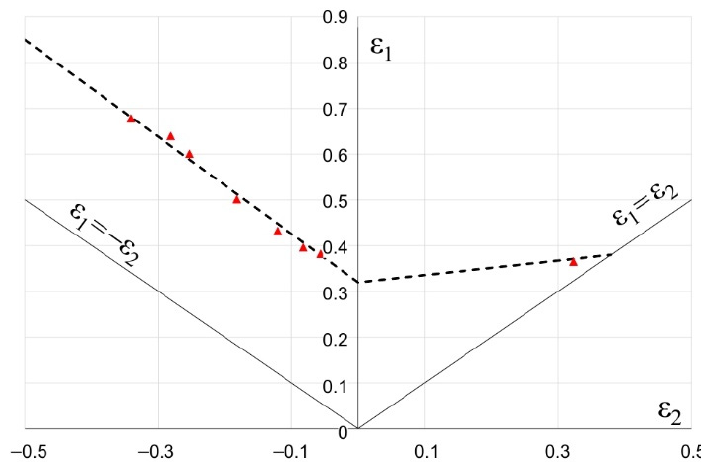
Figure 5. Forming limit diagram for Grade 2 titanium sheet, t = 1.0 mm.